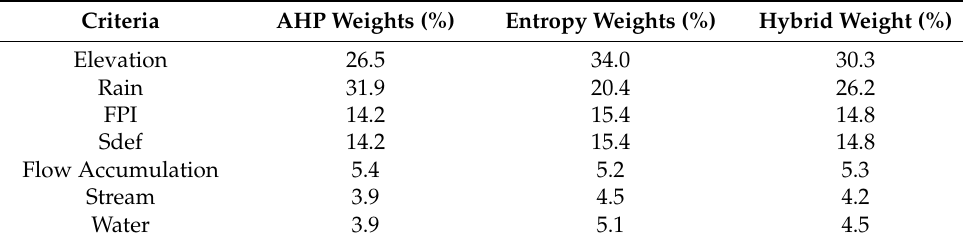
Table 5. Criteria weights from the AHP, Entropy, and Hybrid weighting methods.